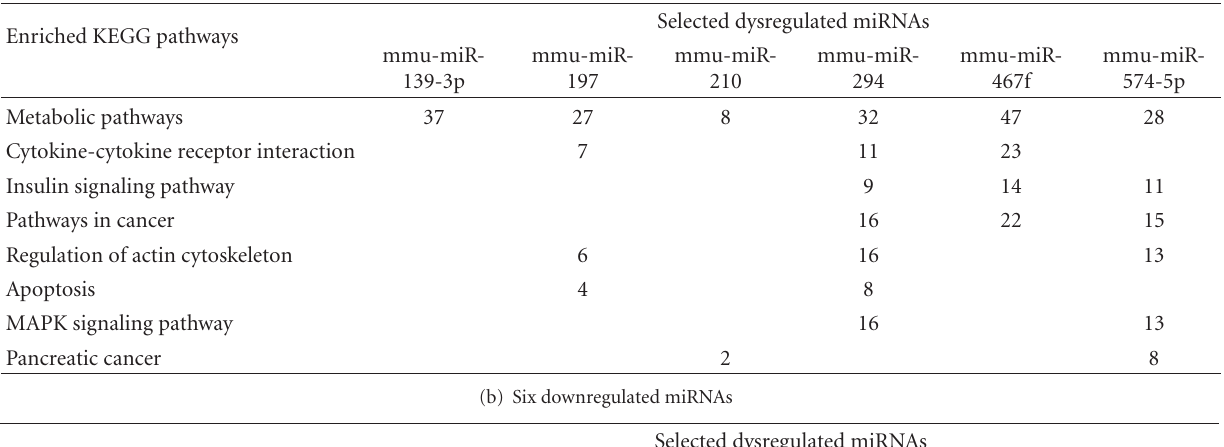
Table 2: Number of targets genes in enriched KEGG pathways for the six up-regulated and the six down-regulated genes. (a) Six upregulated miRNAs Enriched KEGG